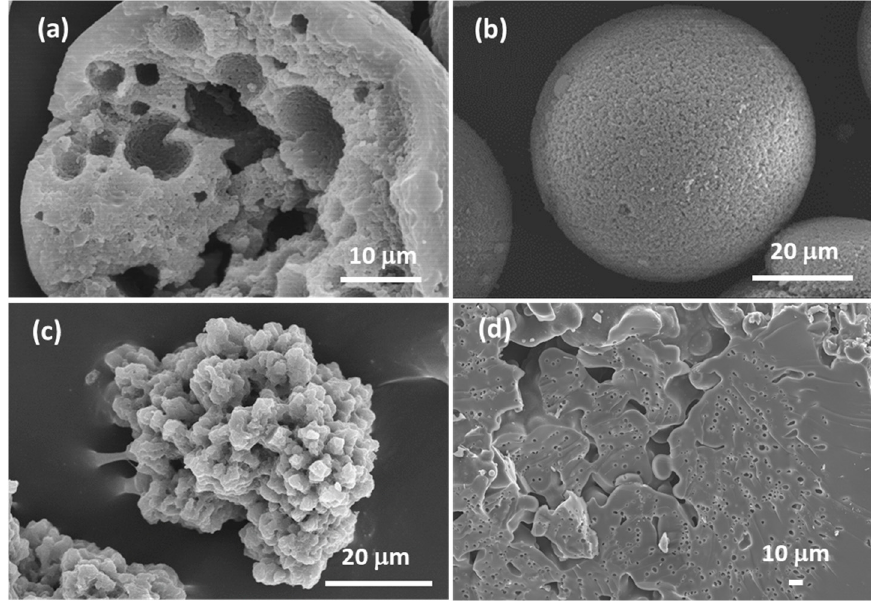
Figure 30. SEM images of microspheres with varied pore morphology, resulting from different freezing and phase separation onsets. ( a ) too early freezing, or retarded phase separation; ( b ) simultaneous freezing and phase separation by spinodal decomposition; ( c ) freezing at the late stage of phase separation; ( d ) macroscopic two phase structure (isolated macropores). (A.C. Marques et al., unpublished results).